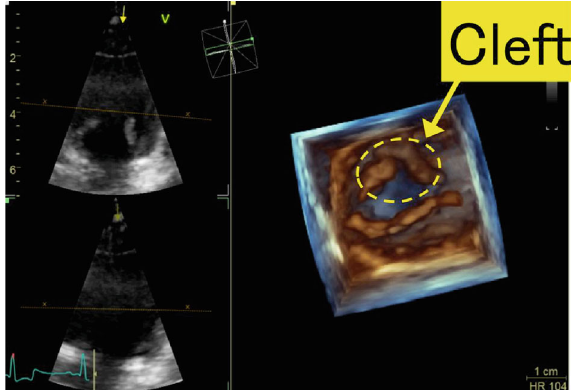
Figure 3: Three-dimensional echocardiographic image of the right parasternal short-axis view at the level of the mitral valve. A cleft of the anterior lea fl et of the mitral valve can be clearly con fi rmed. The cleft is a V shape, with a maximum diameter of 2.1cm and a maximum of crack by cleft width of 0.8